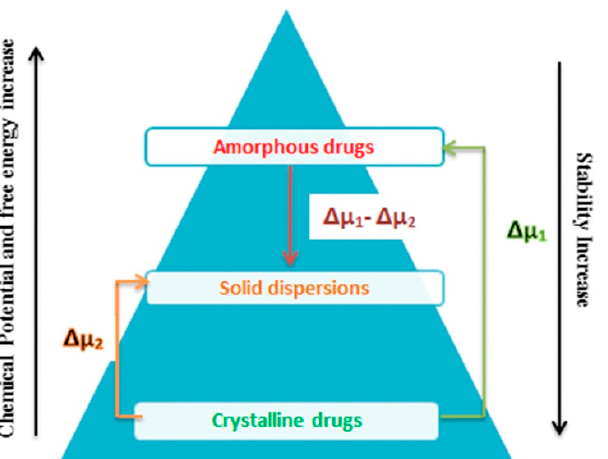
Figure 1. Energetic state pyramid of the crystalline phase, amorphous solid dispersion, and amor- phous phase, where μ denotes the chemical potential. (Adapted with permission from [33], published by John Wiley & Sons, Inc., 2016.)